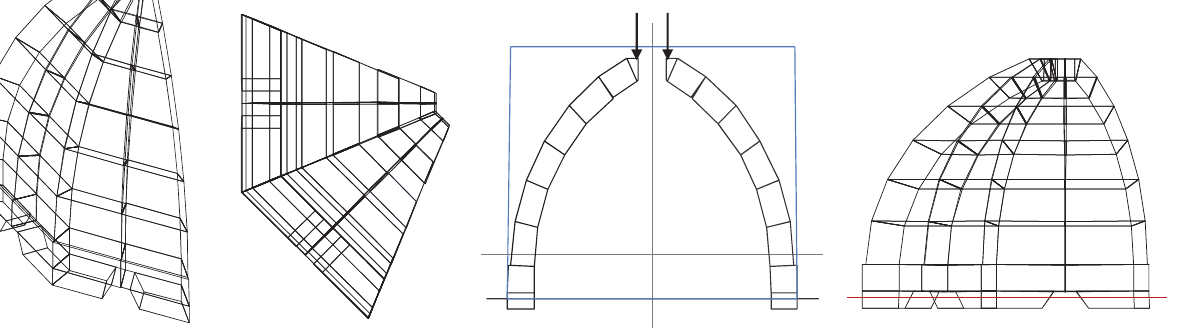
Figure 18: Collapse mechanism of S. Maria del Fiore dome (Mod1)